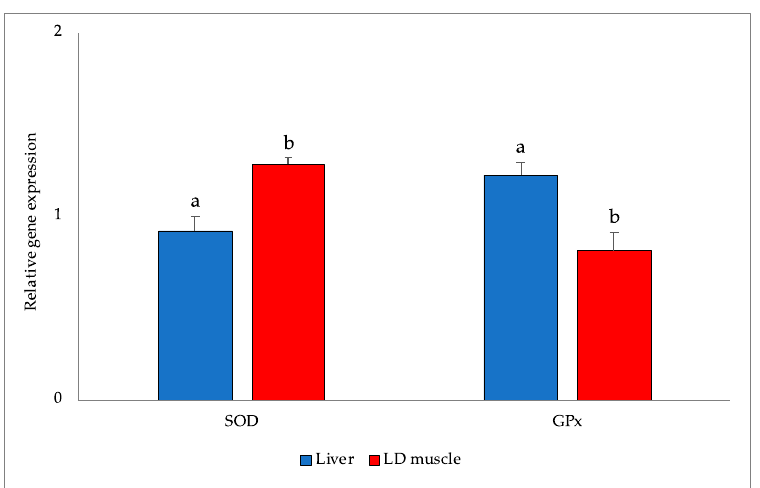
Figure 2. mRNA expression level of SOD and GPx in the liver and LD muscle of rabbits. GPx: glutathione peroxidase; SOD: superoxide dismutase; a,b Means within a row with different letters are significantly different at p < 0.05.